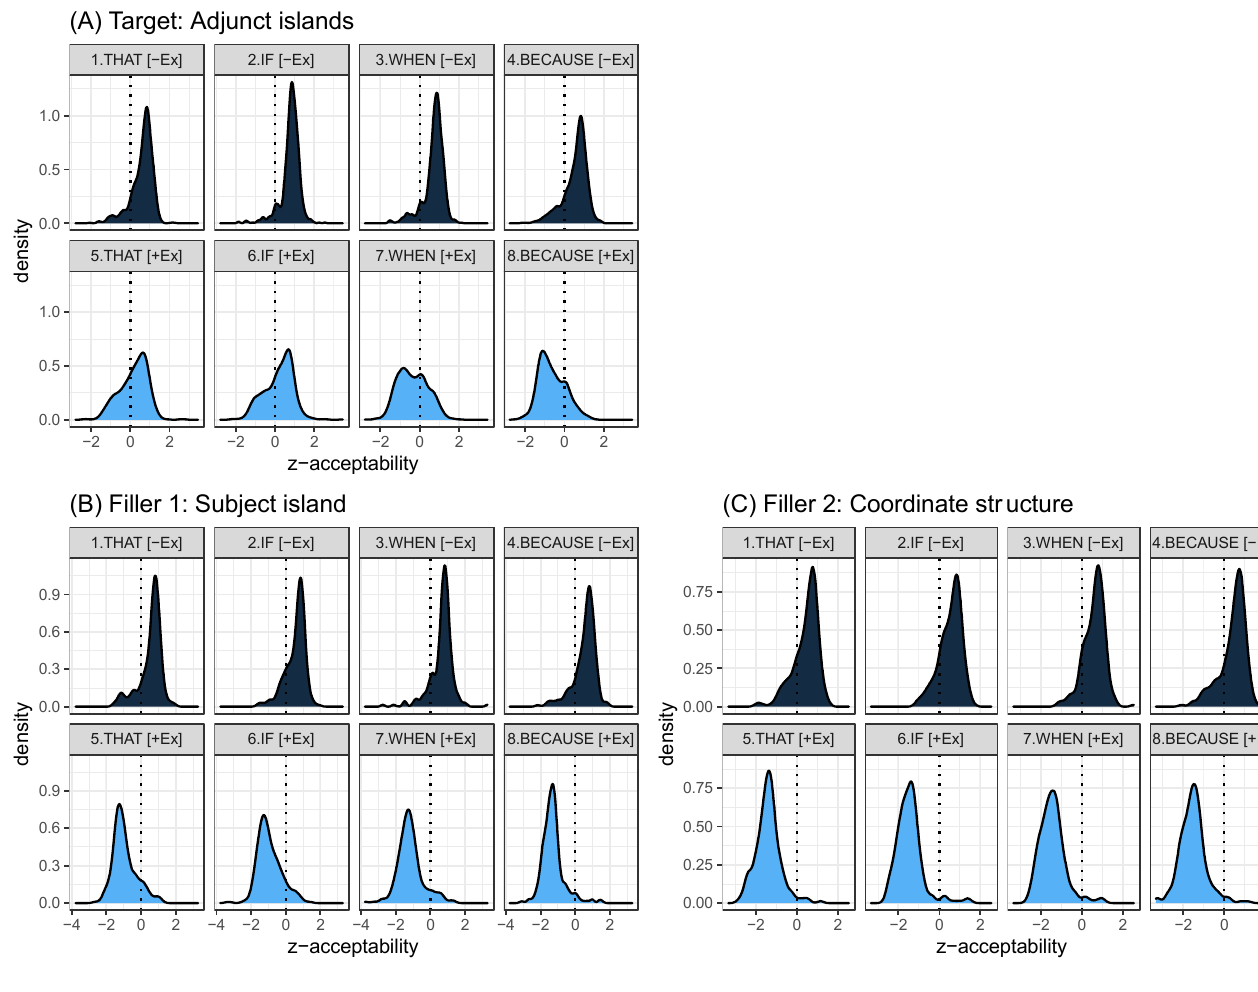
Figure 5. Density plots for each sentence type in the target category ( A ) and in the two fillers, ( B ) and ( C ). Dark blue: [ − Ex], light blue: [+Ex].